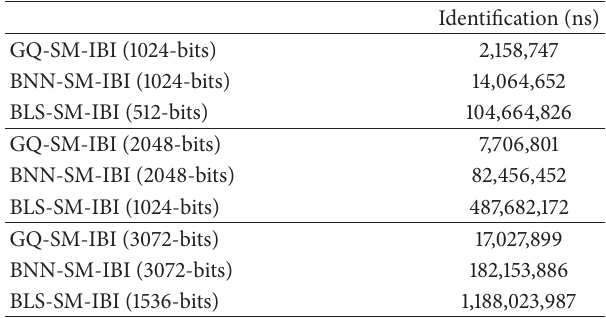
Table 5: Comparison of average simulated runtimes for SM-IBI